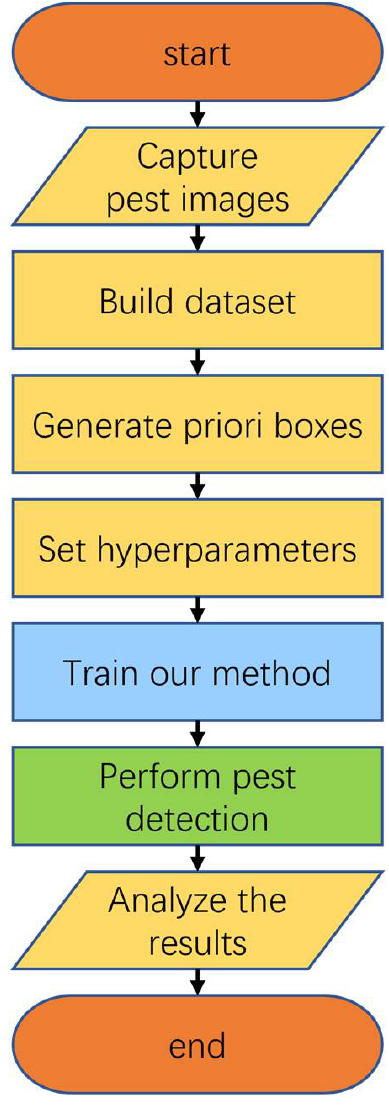
Figure 9. The complete architecture for crop pest detection using our method.